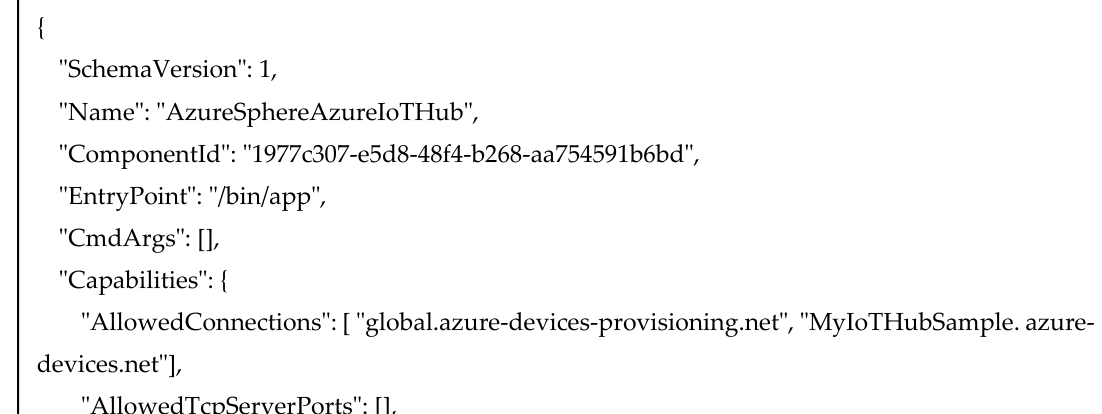
Figure 5. The application manifest file for the project of MT3620 as gateway.